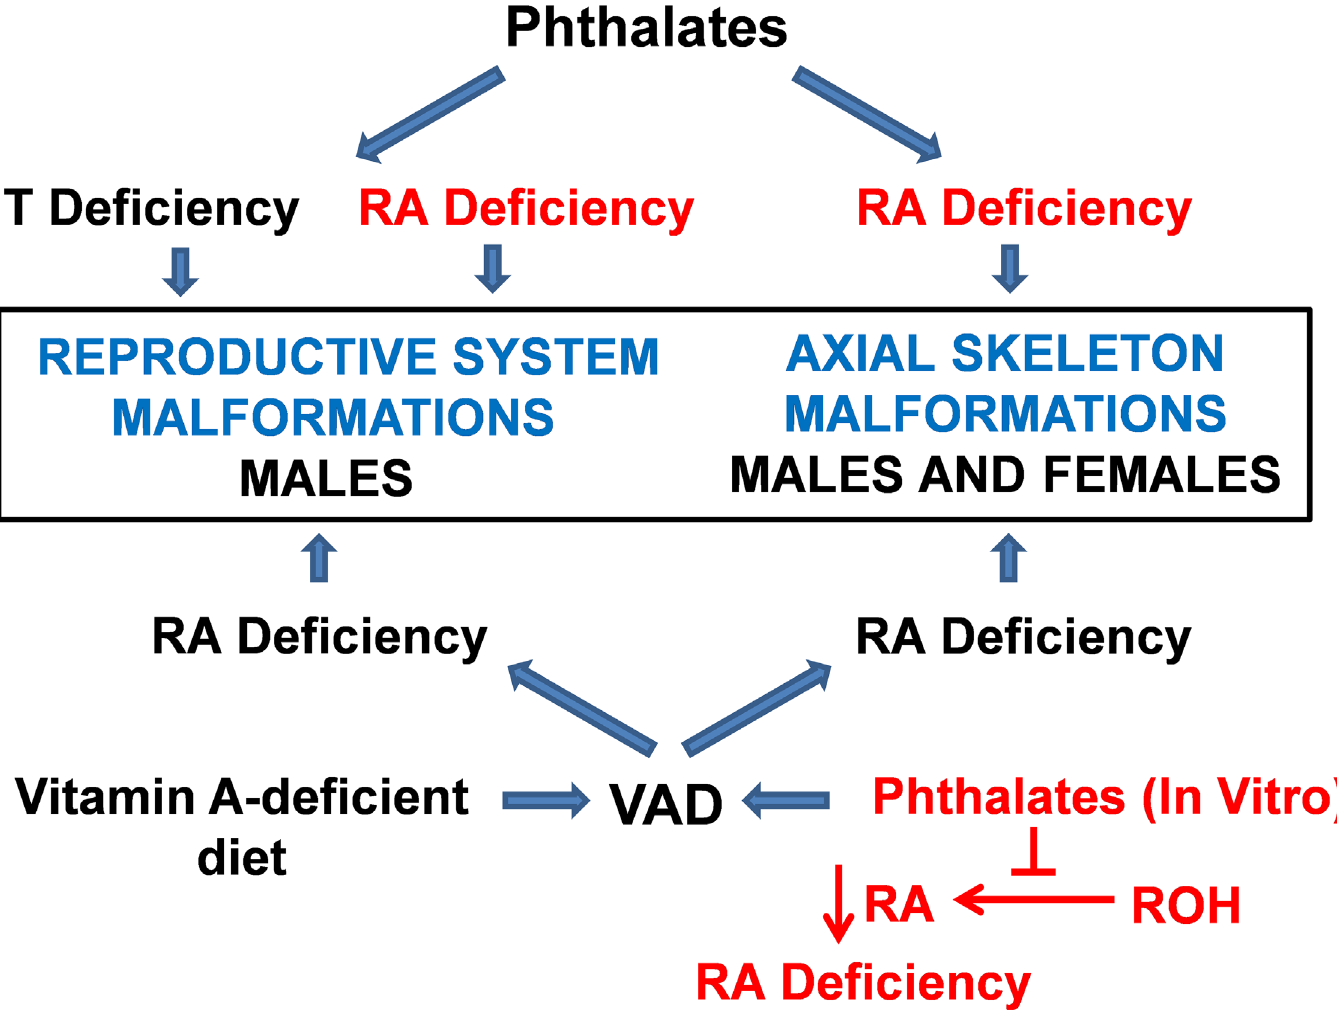
Fig 7. Synopsis of connections between fetal malformations induced by PEs and RA deficiency. Gestational exposure to some phthalates or to a VAD (vitamin A deficient/RA deficient) diet cause a characteristic spectrum of malformations (dysgenesis of seminiferous tubules, seminal vesicles, epididymis, prostate, genital tubercle/hypospadias, and cryptorchidism) in the reproductive system of the male rat fetus; phthalates or VAD also cause malformations in the axial skeleton of both sexes. PE-mediated fetal testosterone (T) deficiency is generally considered to be the cause of male reproductive system malformations. Given that PEs also caused cellular RA deficiency in this in vitro study, PE-mediated RA deficiency is hypothesized (indicated in red) to be an additional cause of malformations in the male rat reproductive system and axial skeleton in